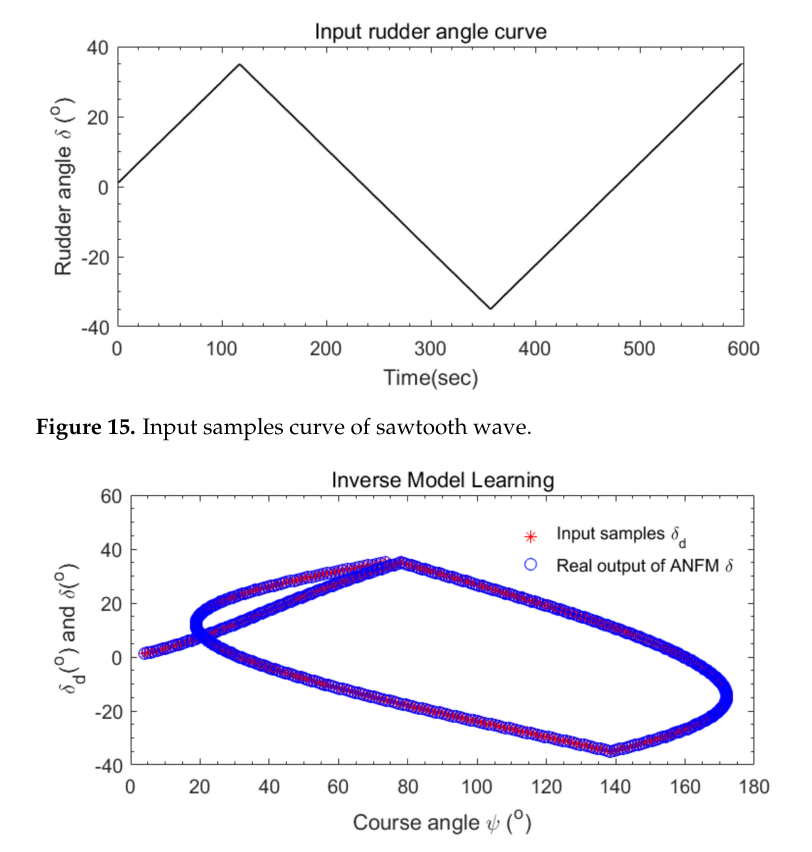
Figure 16. Comparison curve between input samples and ANFM actual outputs.